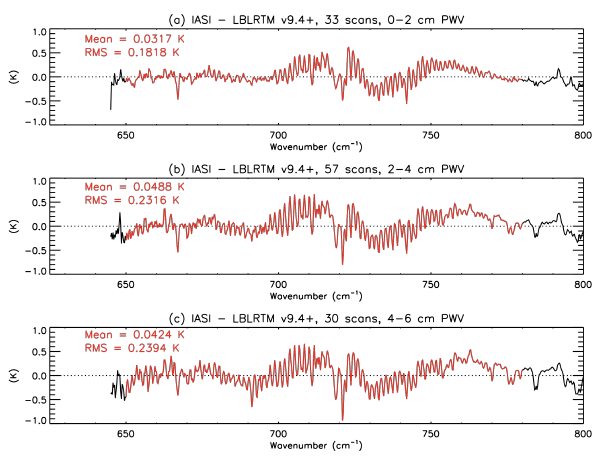
Fig. 5. Mean final (a posteriori) brightness temperature residuals in the CO 2 ν 2 band using LBLRTM v12.1 as in Fig. 3b, but only for profiles with (a) 0 to 2cm, (b) 2 to 4cm, and (c) 4 to 6cm of precipitable water vapor (PWV).